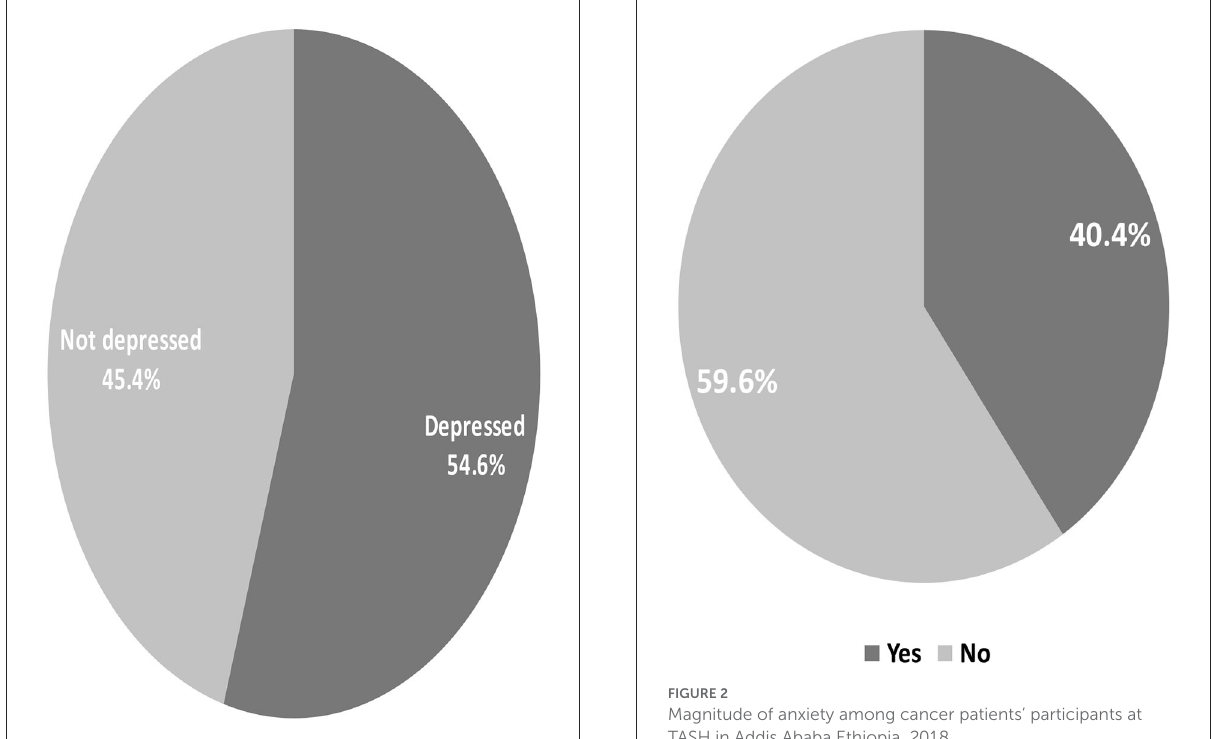
FIGURE1 Magnitude of depression among cancer patient participants, at TASH in Addis Ababa Ethiopia, 2018.